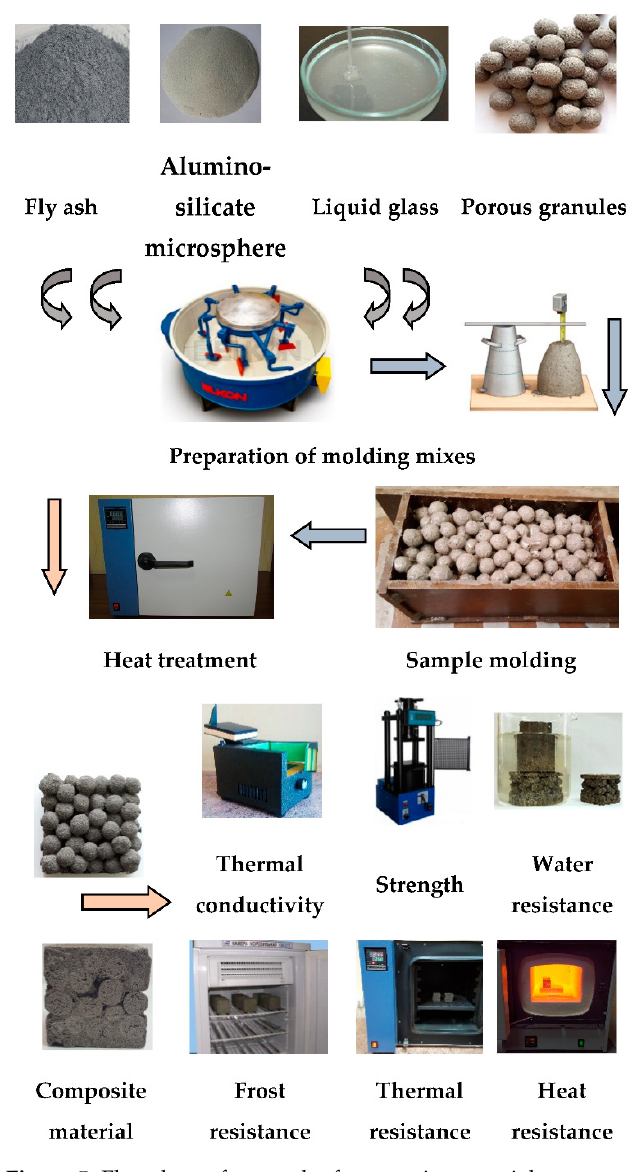
Figure 5. Flowchart of research of composite materials.